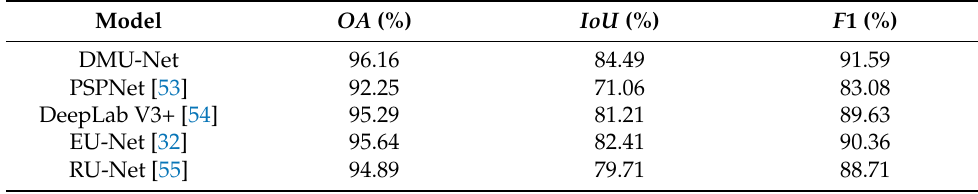
Table 2. Building extraction accuracy corresponding to different network structures.